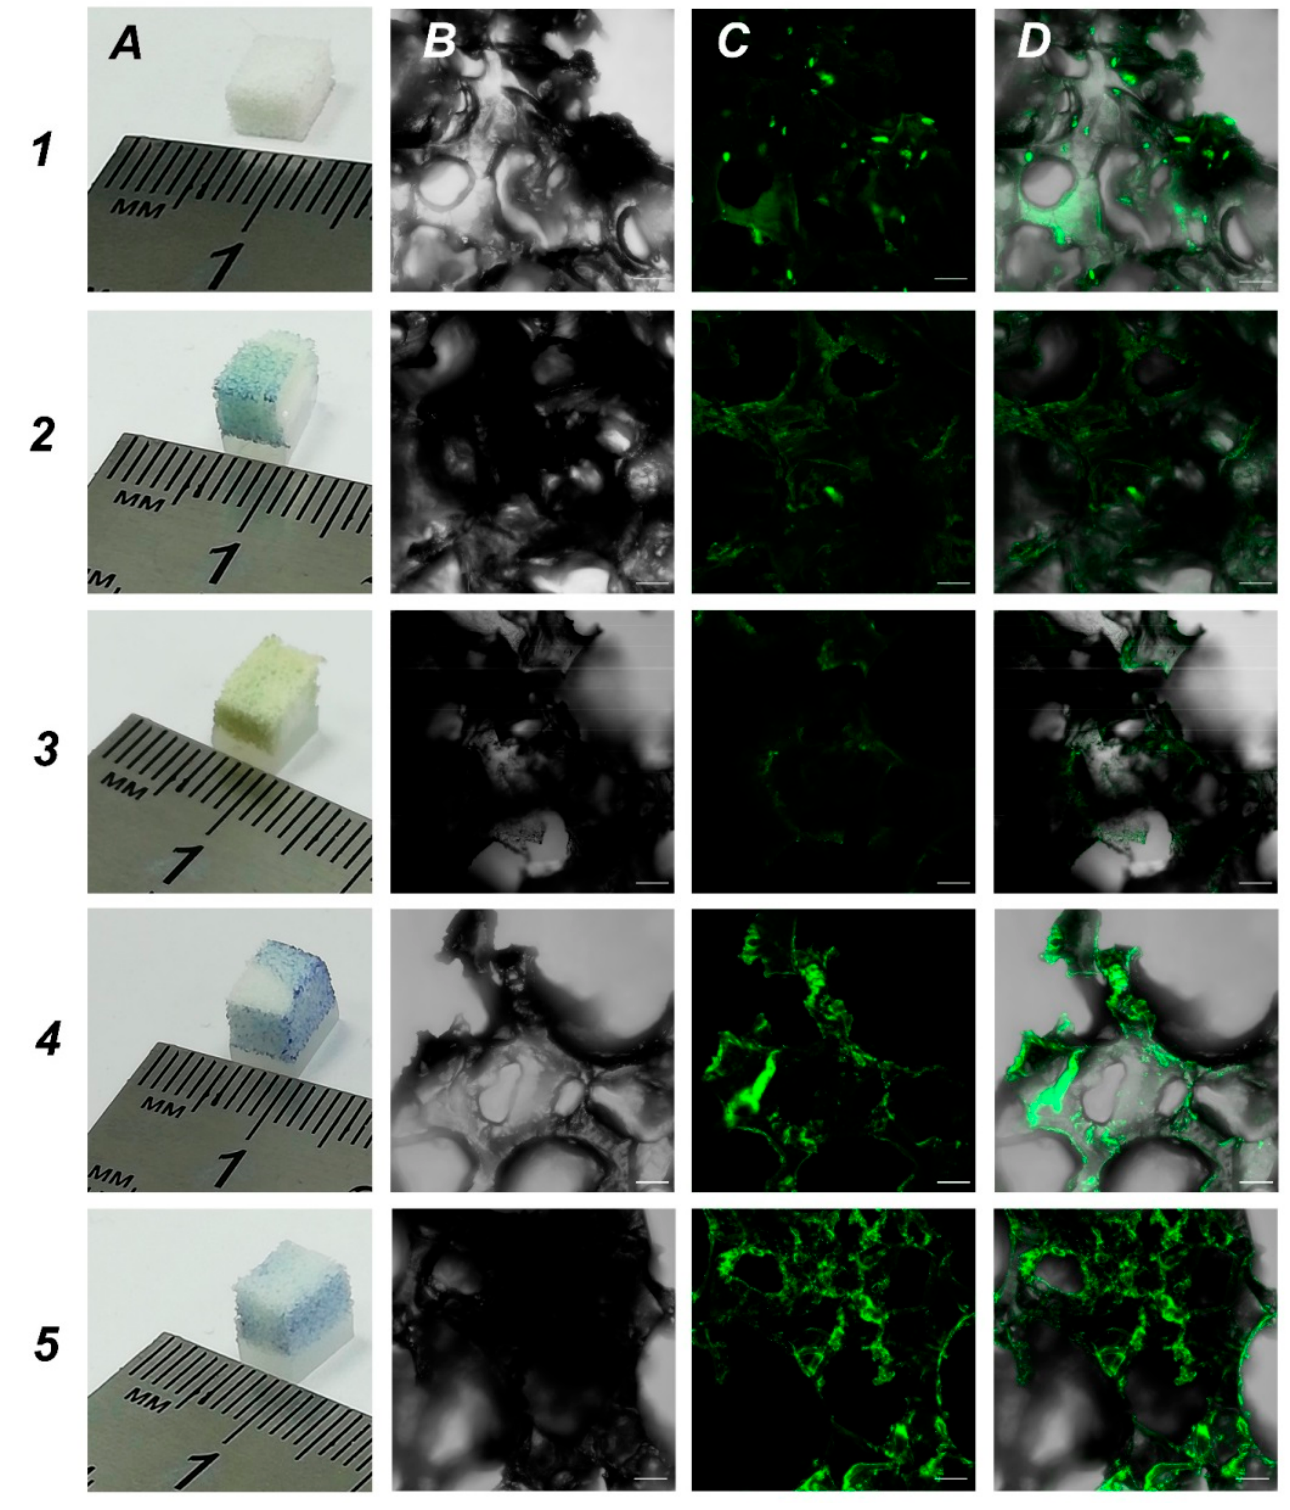
Figure 4. Visualization of SH-SY5Y-F15 cell growth on UHMWPE treated with various biopolymer compounds. Rows: 1—unmodified UHMWPE, 2—0.1% gelatin, 3—0.01% poly-L-lysine, 4—0.1% BSA, 5—0.1% chitosan. Panels: ( A )—macro photographs of non-treated and treated UHMWPE; ( B )—phase-contrast imaging (grey); ( C )—SH-SY5Y cell expressing GFP (green); ( D )—merged images ( B ) and ( C ). Scales for ( B – D )—100 µ